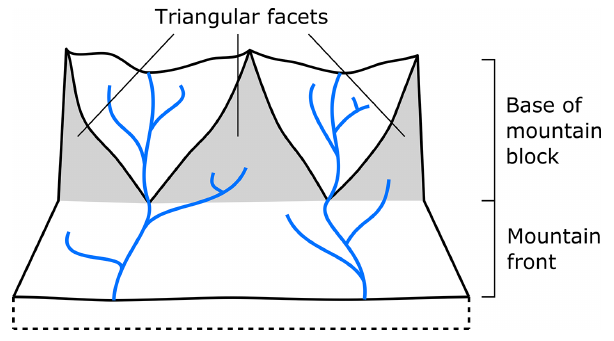
Figure 3. Schematic diagram showing triangular facets at the base of the mountain block (after Welch and Allen